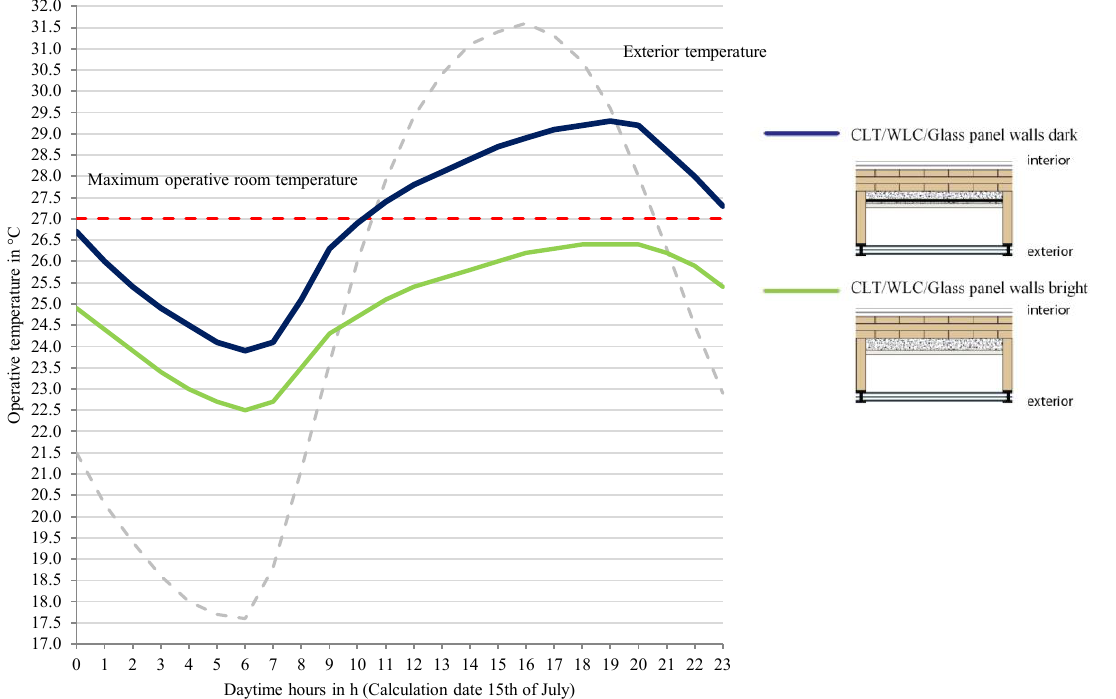
Fig. 6 Operative room temperatures of timber-wood concrete-glass façades with bright and dark plaster